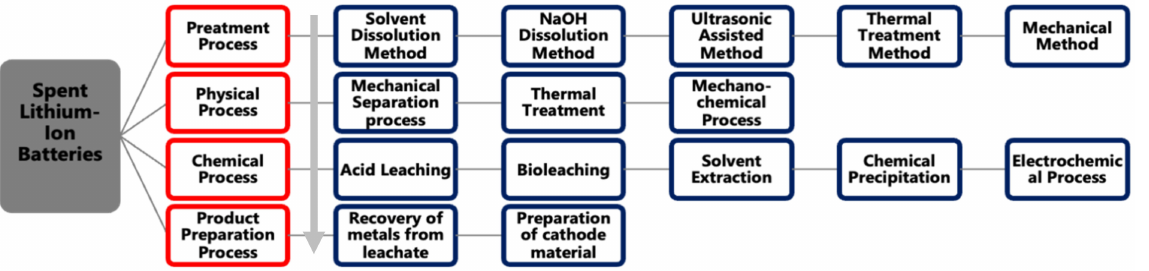
Figure 7. Recycling mythologies for spent Li-ion